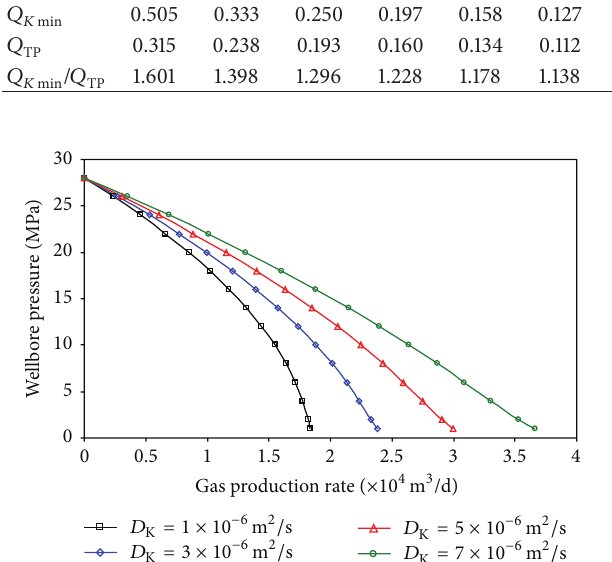
Figure 10: Effect of Knudsen diffusion coefficient 𝐷